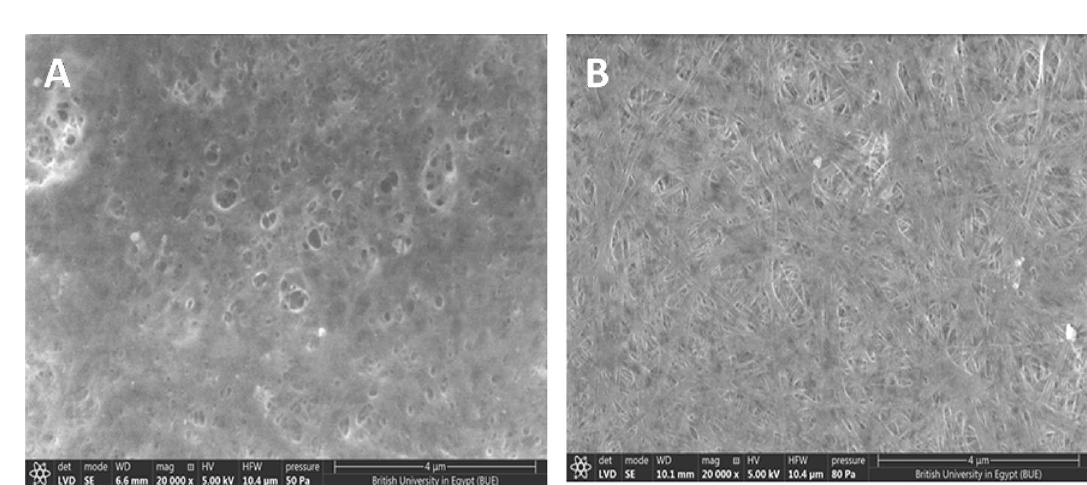
Figure 6. SEM image of BC obtained from HS medium ( A ) and from EDCFs based medium ( B ) at magnification power